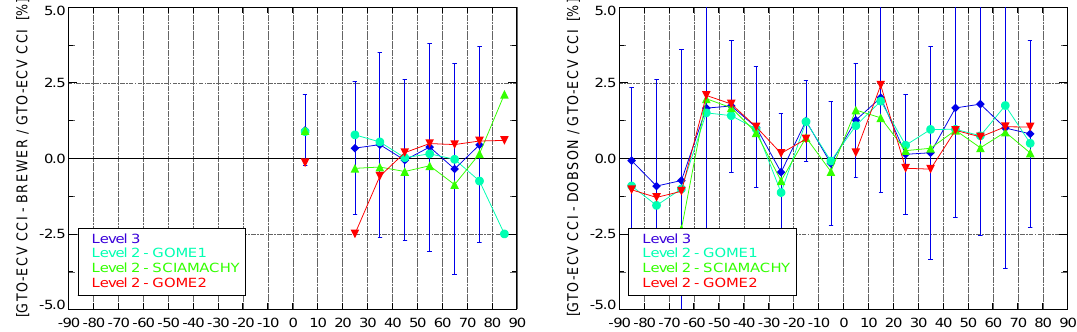
Figure 8. Percentage difference between satellite data records and ground-based data as a function of latitude. Left: Brewer comparisons and right: Dobson comparisons. Level 3 comparison in dark blue, GOME level 2 comparison in light blue, SCIAMACHY in green, and GOME-2A in red. The 1- σ standard deviation of the average is only given for the level 3 lines.